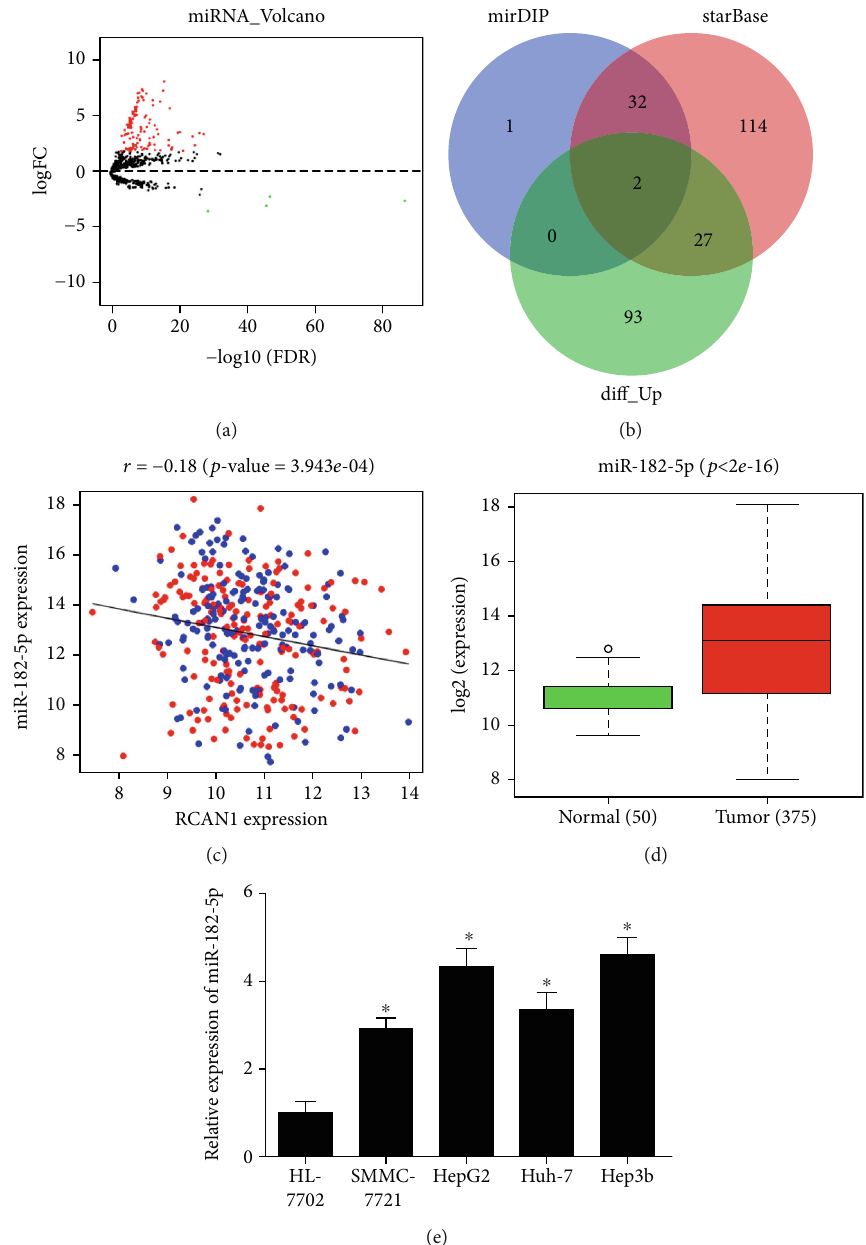
Figure 3: miR-182-5p is highly expressed in liver cancer cells. (a) Volcano map of DEmiRNAs in liver cancer data set of TCGA database (red represents up-regulated genes, green represents downregulated genes); (b) Venn diagram of predicted upstream miRNAs of RCAN1 and DEmiRNAs; (c) Pearson correlation analysis between RCAN1 and miR-182-5p; (d) Relative expression of miR-182-5p in the normal group and tumor group in TCGA (green represents the normal group, red represents the tumor group); (e) the expression of miR-182-5p in the human normal liver cell line HL -7702 and human liver cancer cell lines SMMC-7721, HepG2, Huh-7, and Hep3b was detected by qRT-PCR; ∗ p < 0 : 05